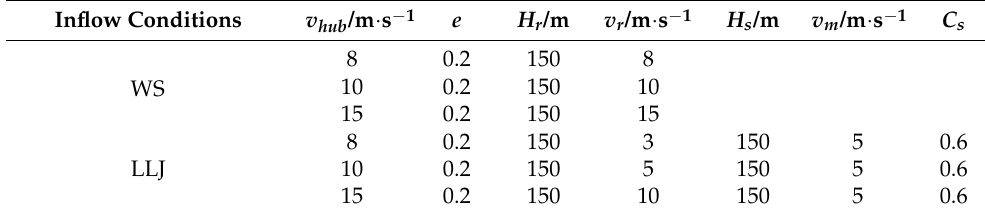
Table 4. The parameters of various calculation conditions.